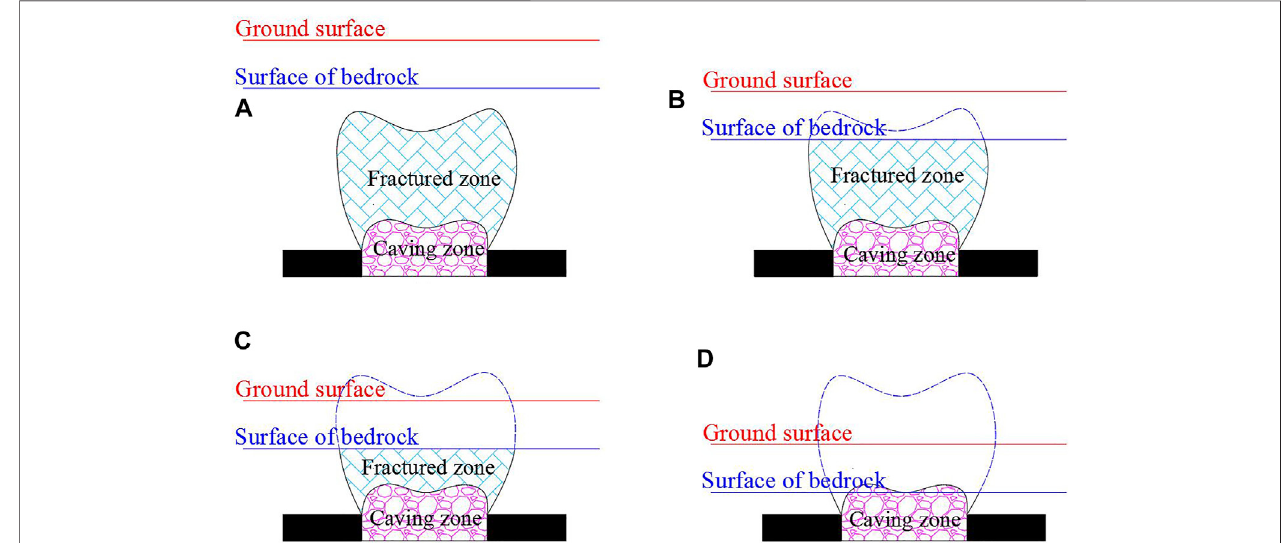
FIGURE 8 | Develop types of overlying strata.